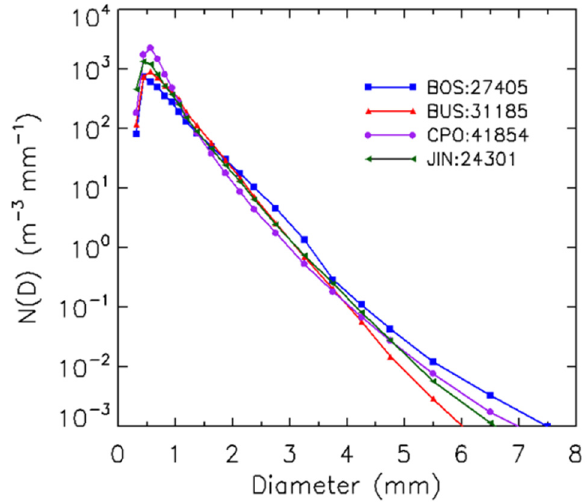
Figure 4. Average raindrop number concentration with diameter at four different sites. The rectangles in blue represent BOS, the triangles in red represent BUS, the circles in purple represent CPO, and the arrows in green represent the JIN site. The numbers in the legend are sampling numbers at each site.